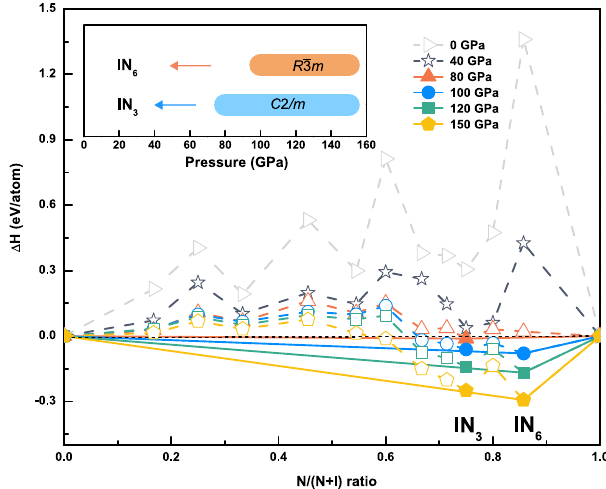
Fig. 1 Phase stabilities of I – N compounds. The formation enthalpy of various I – N compounds under various pressures. The dotted lines connect the data points, and the solid lines denote the convex hull. The stable pressure ranges for IN 3 and IN 6 are shown in the inset. Source data are provided as a Source Data fi